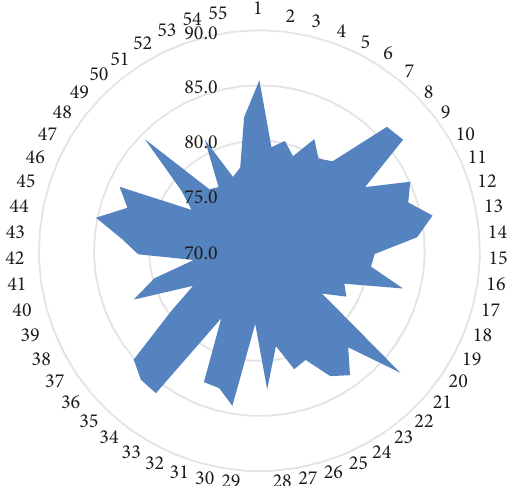
Figure 6: Statistical diagram of the detection effect of the automatic detection method of building cracks based on digital image pro- cessing technology and multiscale feature analysis automatic de- tection